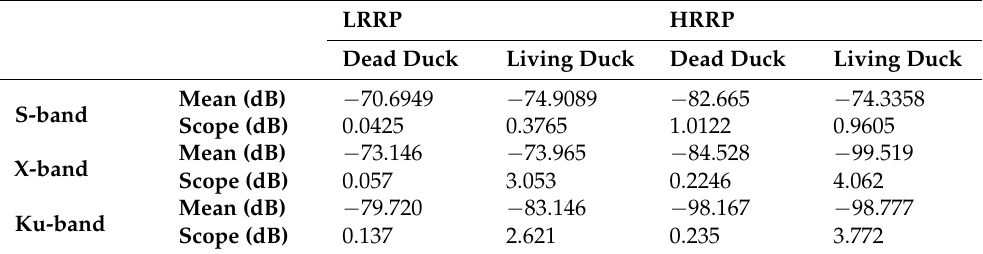
Table 2. Some statistics results of signal fluctuations in Figures 4 and 5.